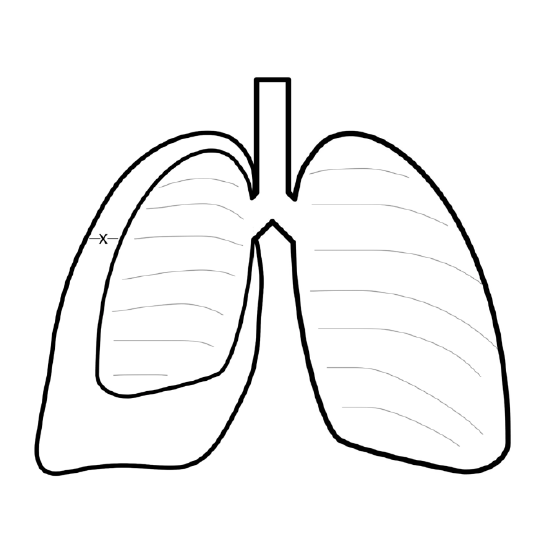
Figure 1. The presence of separation greater than 2 cm from the lateral chest wall (X) at the level of the hilum was classified as "large